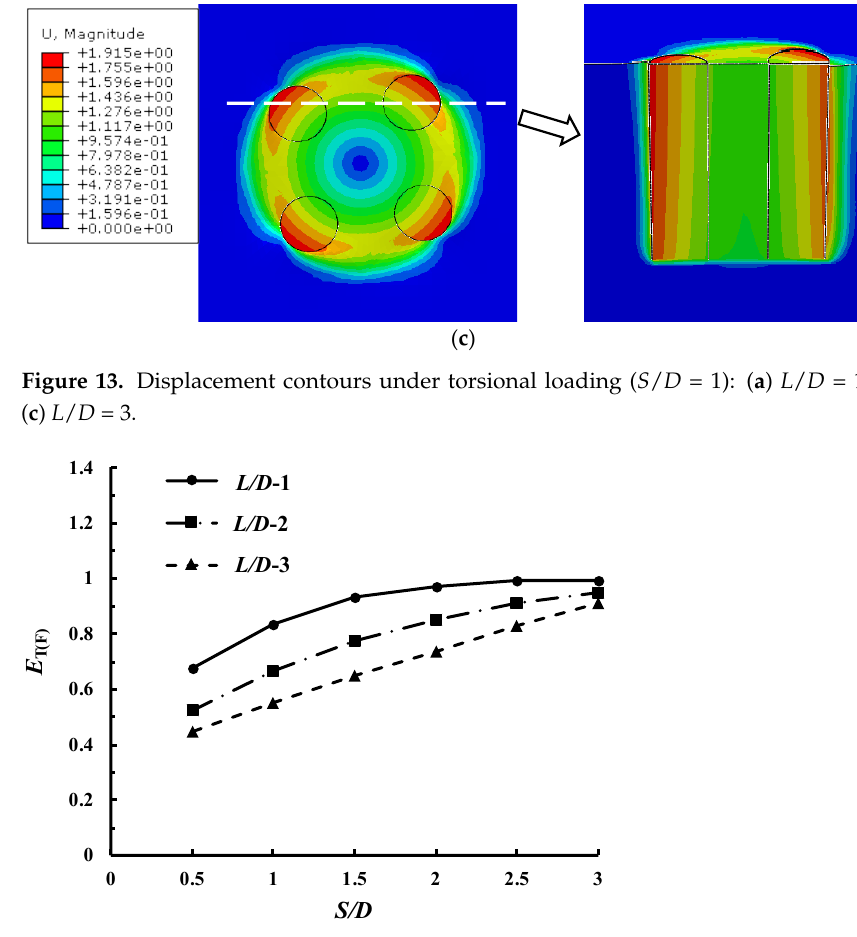
Figure 13. Displacement contours under torsional loading ( S / D = 1): ( a ) L / D = 1; ( b ) L / D = 2; ( c ) L / D = 3.